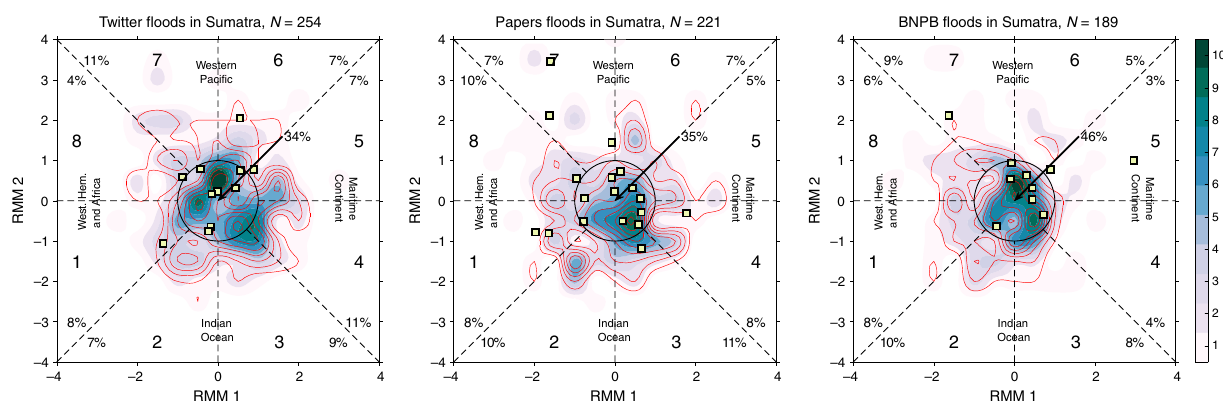
Fig. 5 Aggregate fl oods on Sumatra in meteorological context. Flood periods in Sumatra between 2014 and 2018 from the Twitter ( a ), papers ( b ) and Indonesian National Board for Disaster Management ( c ) databases. Data presented on the RMM phase diagrams representing Madden Julian Oscillation (MJO) strength and location at the beginning of a fl ood. Shading indicates the number of fl oods associated with any convectively coupled Kelvin wave (CCKW) and contours indicate number of fl oods initiated during a strong CCKW event (contour interval is one). Rare fl oods occurring without any CCKW activity are marked with yellow squares. The MJO is considered active on days when its amplitude is above 1 (outside the unit circle) and location of active convection is represented in the phase. Phases 2 and 3 represent active MJO over Indian Ocean, phases 4 and 5 over the Maritime Continent, phases 6 and 7 over the Western Paci fi c and phases 8 and 1 over the Western Hemisphere and Africa. Percents indicates number of fl oods which occurred during each phase of the MJO and during no MJO activity. Total number of fl ood periods is indicated in the title of each